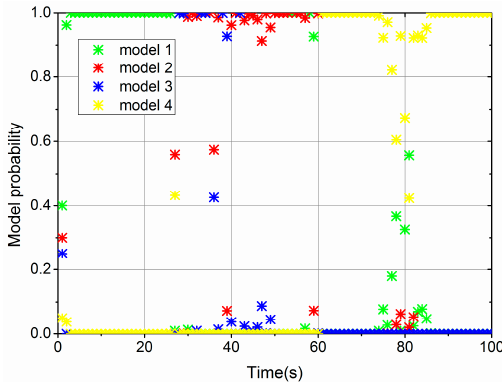
Figure 8. The model probabilities by using UIMM in simulation 2.